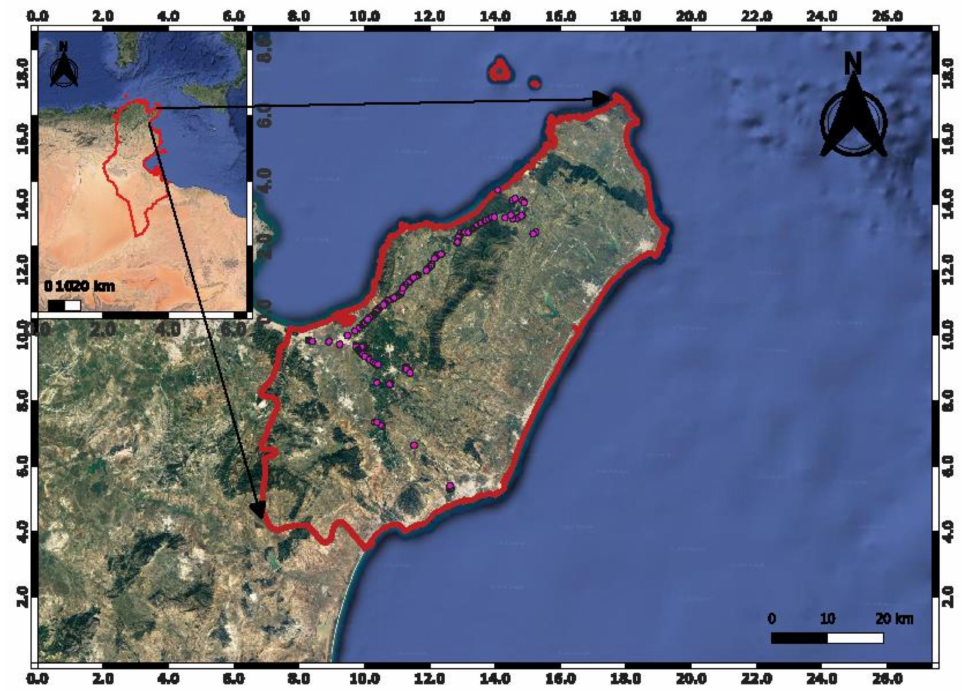
Figure 1. Presentation of the study area, and GPS point indicating field visits to collect ground truth